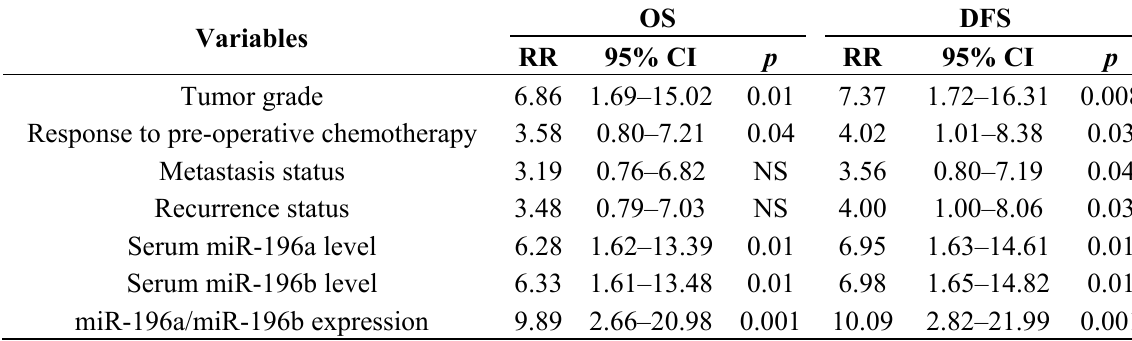
Table 2. Multivariate survival analysis of overall survival (OS) and disease-free survival (DFS) in 100 patients with